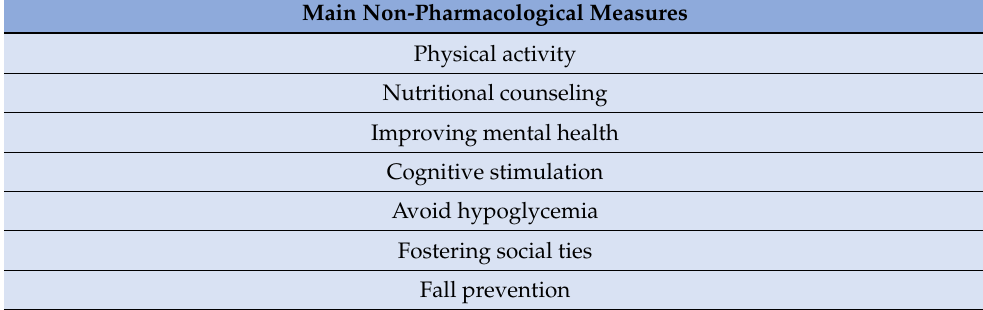
Table 3. Main non-pharmacological measures in T2DM with frailty and/or